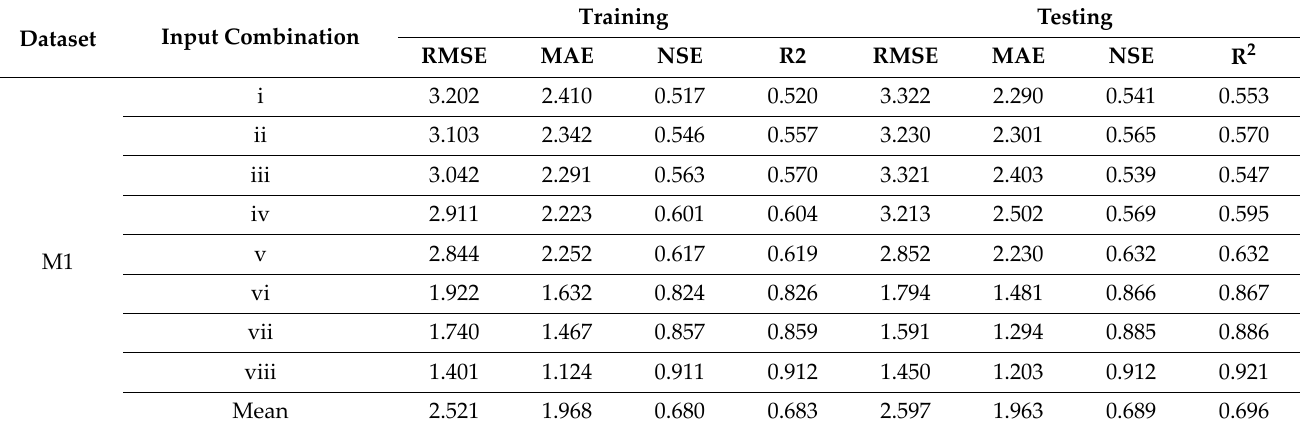
Table 3. The results of the model RVFL for monthly time